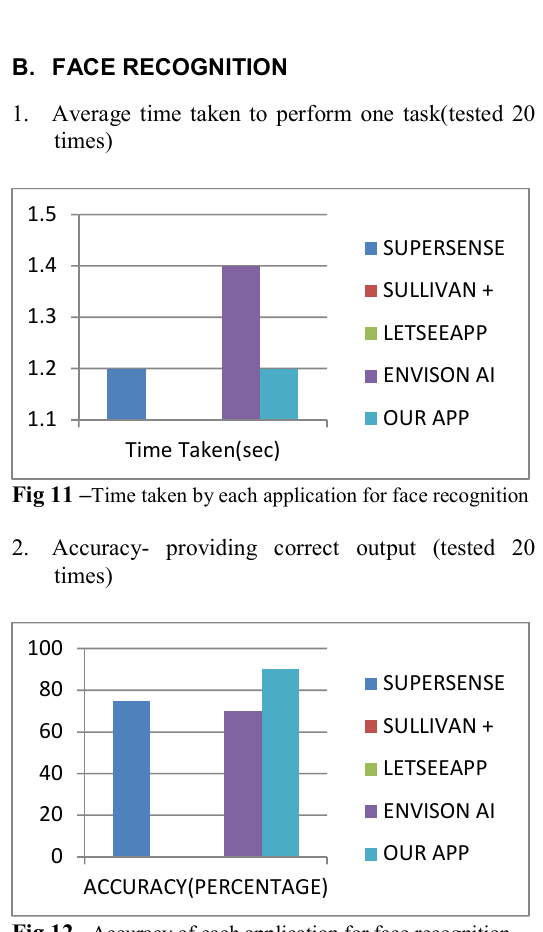
Fig 12 – Accuracy of each application for face recognition C. TEXT RECOGNITION